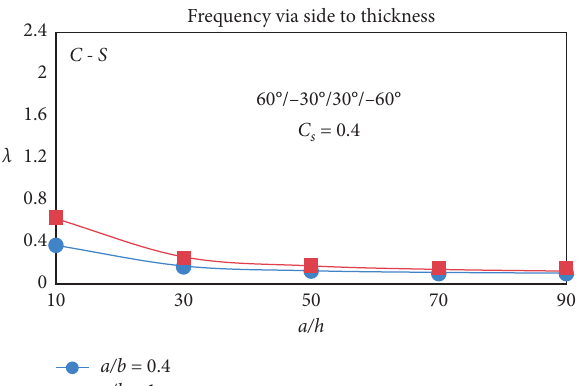
Figure 10: Influence of side-to-thickness ratio on frequency parameter value of 4-layered plates under C-S support condition.